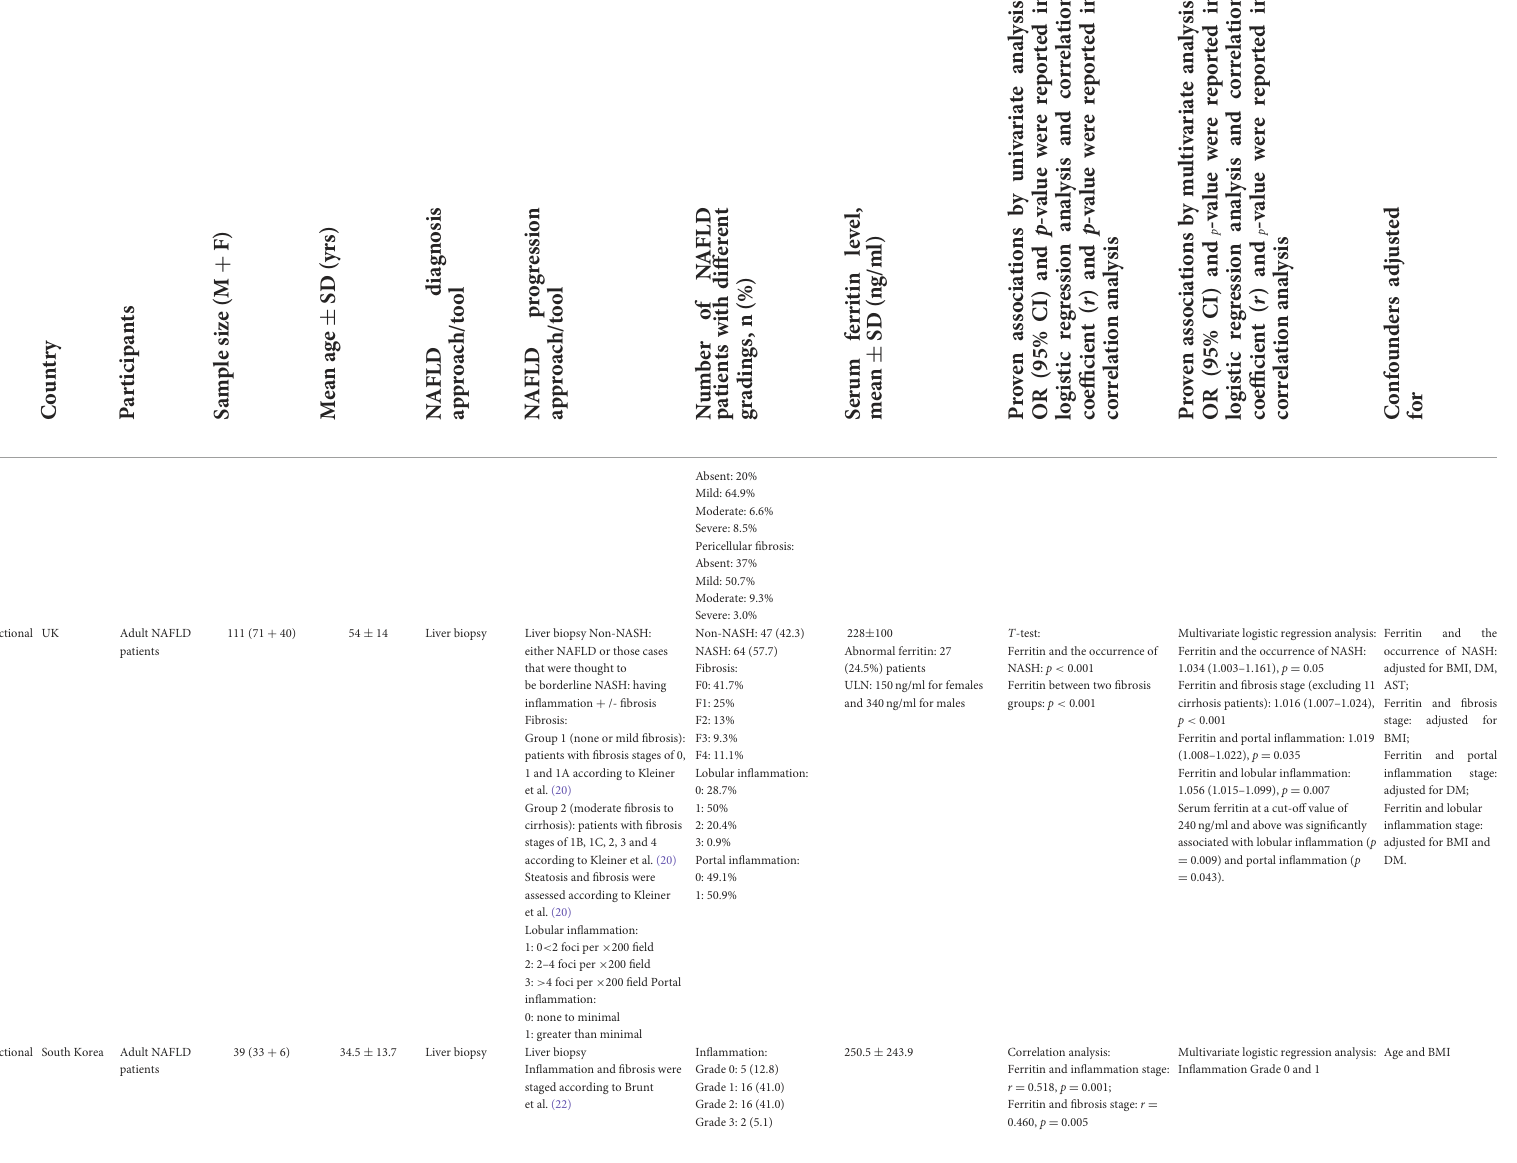
Correlationanalysis: